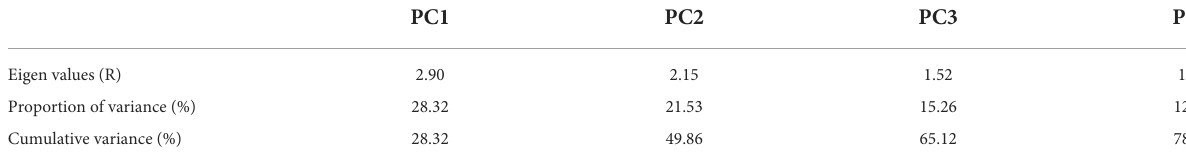
TABLE 4 Principal component analysis depicting the eigen values and variation percentages under exposure indicator.